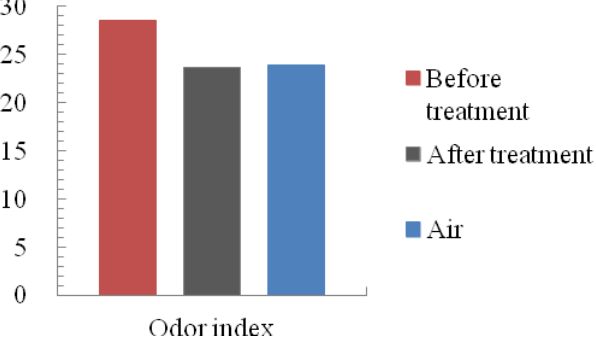
Figure 12. The odor index of before, after HCHO treatment and room